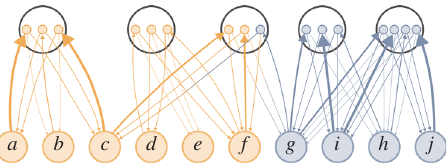
Fig. 2 Bipartite network with state nodes for non-lazy random walks. White circles with black borders represent hyperedges, and small, coloured circles within the hyperedges represent the state nodes. To prevent random walks on bipartite networks from visiting the same node at the bottom twice in a row by backtracking from the hyperedge node at the top, we use state nodes in the hyperedge nodes. Each hyperedge node requires one state node for each node in the hyperedge. The state nodes have one incoming link from its source node and outgoing links to all other nodes in the hyperedge. Colours indicate the optimised partition. The links' thicknesses are proportional to the random walks' transition